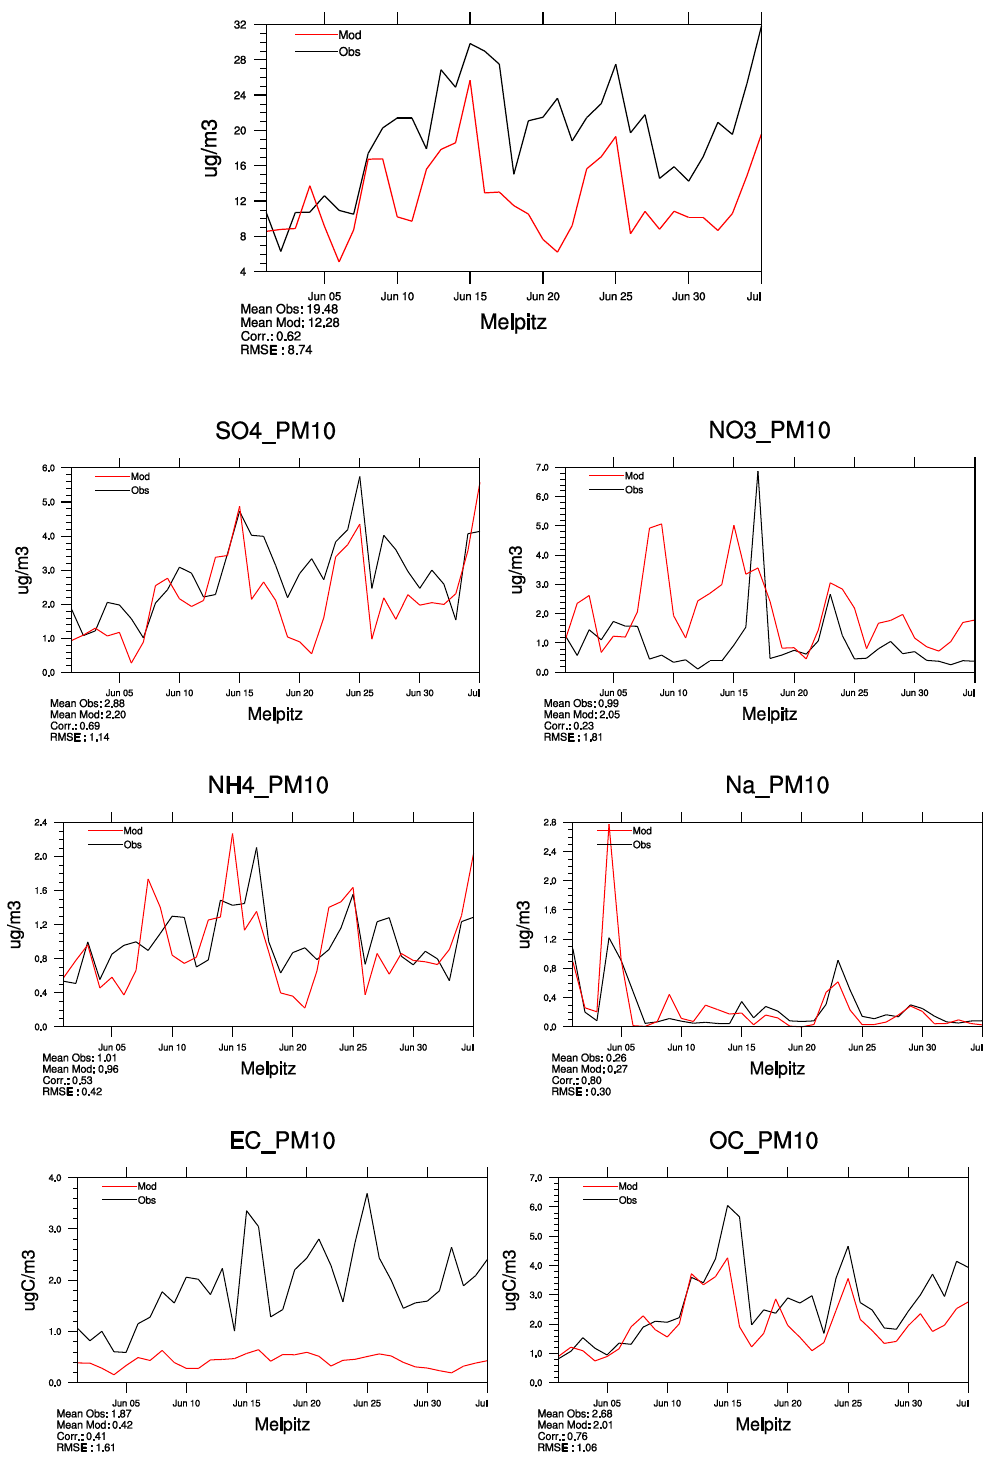
Fig. 7. Filter and denuder measurements of sulphate, nitrate and ammonium concentrations at Montelibretti, IT01. Denuder total denotes total mass of SO 4 , NO 3 and NH 4 without size cut